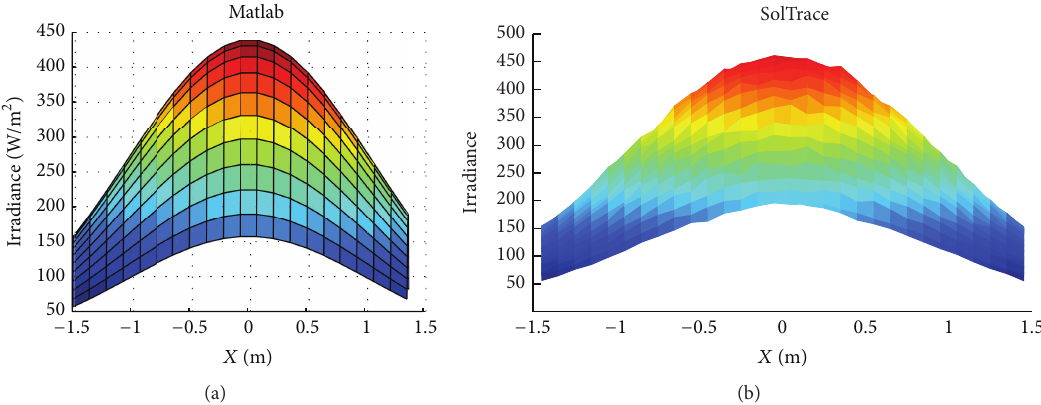
Figure 6: Comparative of solar flux in the receiver. Analytical approximation (a) and Monte Carlo method using SolTrace (b). Far heliostat located at ( − 67.5,